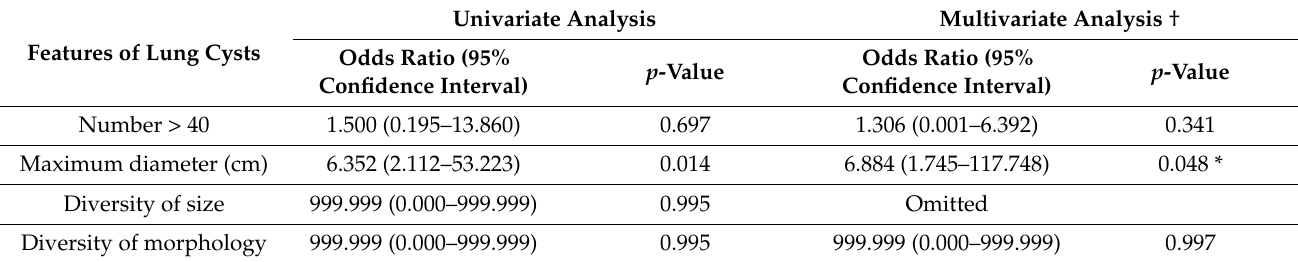
Table 4. Logistic regression between radiologic features and BHD.